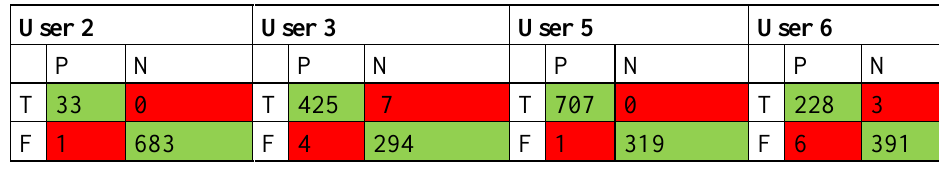
Table 16. SCR confusion matrix for annoying sounds I.